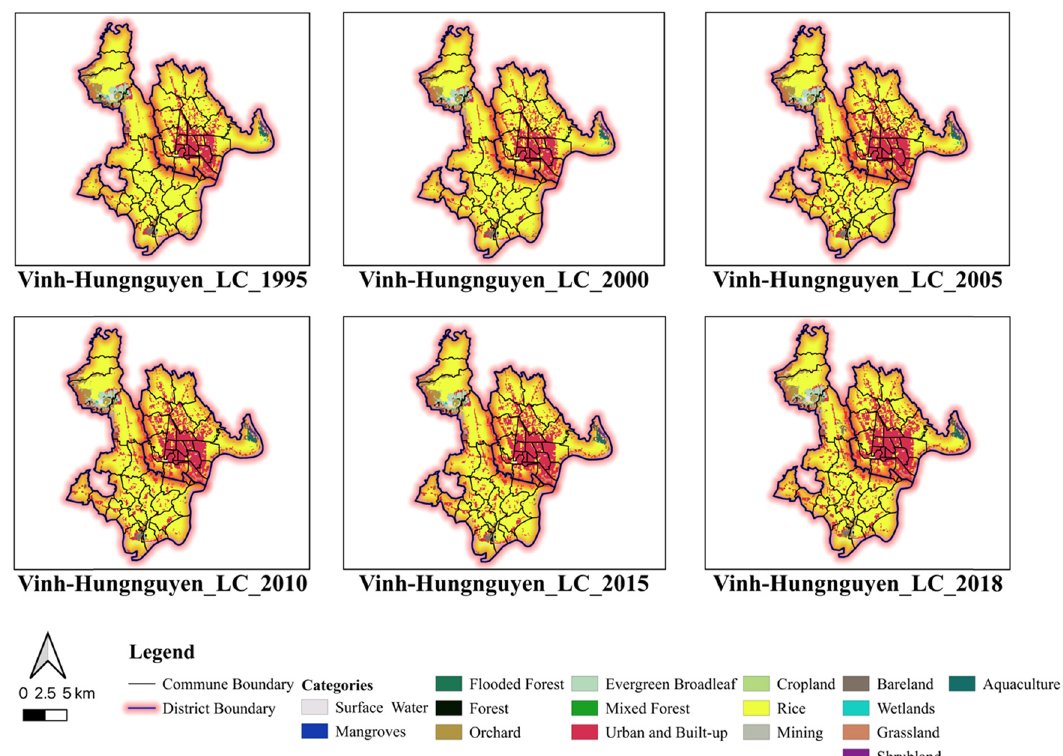
Figure 1: Land cover in Vinh City and Hung Nguyen district over the